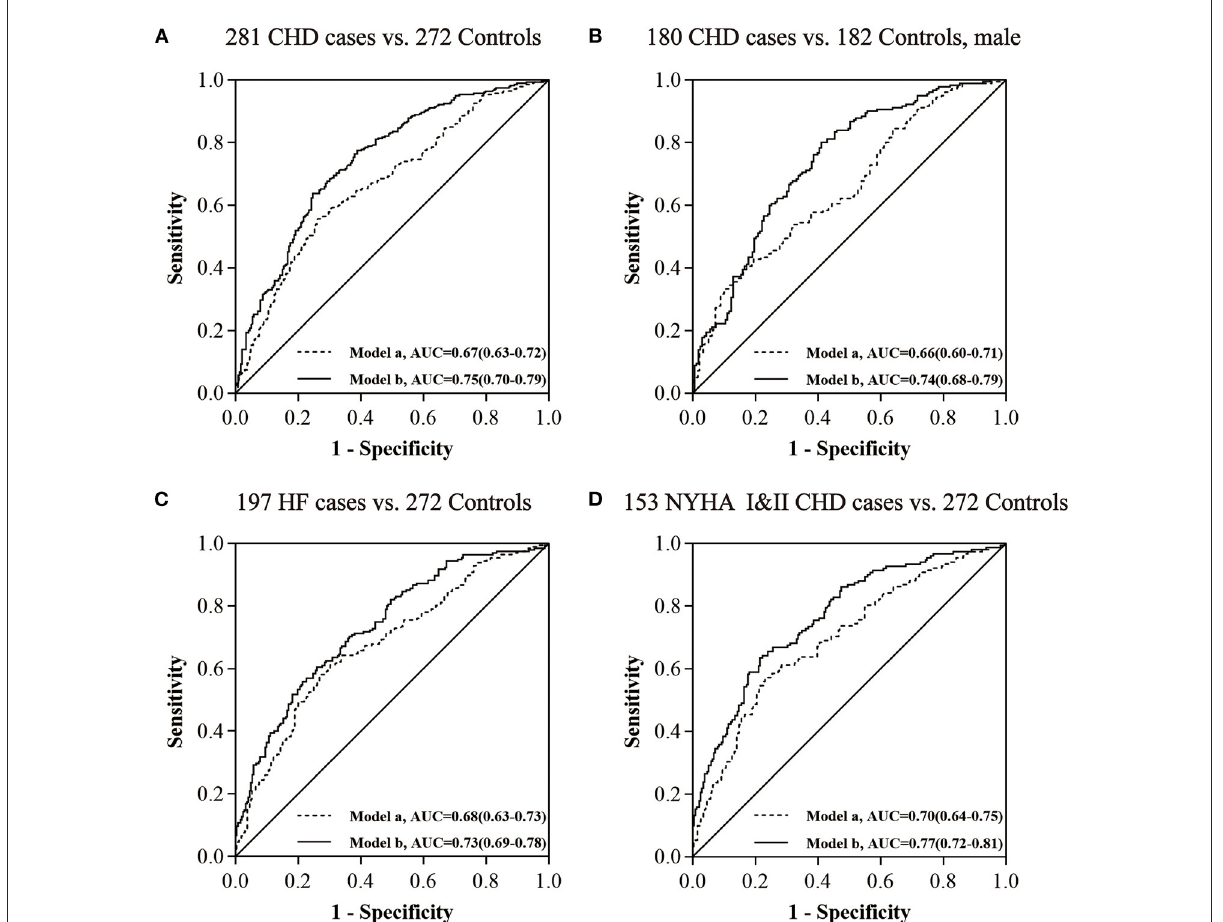
FIGURE2 The power of ACTB (ACTB_CpG_2.3, ACTB_CpG_7.8, and ACTB_CpG_9.10) methylation to distinguish CHD cases from controls. (A) The discrimination of CHD cases from controls by ACTB methylation. (B) The discrimination of CHD cases from controls in males by ACTB methylation. (C) The discrimination of HF cases from controls by ACTB methylation. (D) The discrimination of NYHA I&II CHD cases from controls by ACTB methylation. The ROC analyses were calculated by logistic regression models (model a adjusted for age, gender, and batch effect, and model b adjusted for age, gender, smoking, hypertension, diabetes, TC, TG, LDL–C, and batch